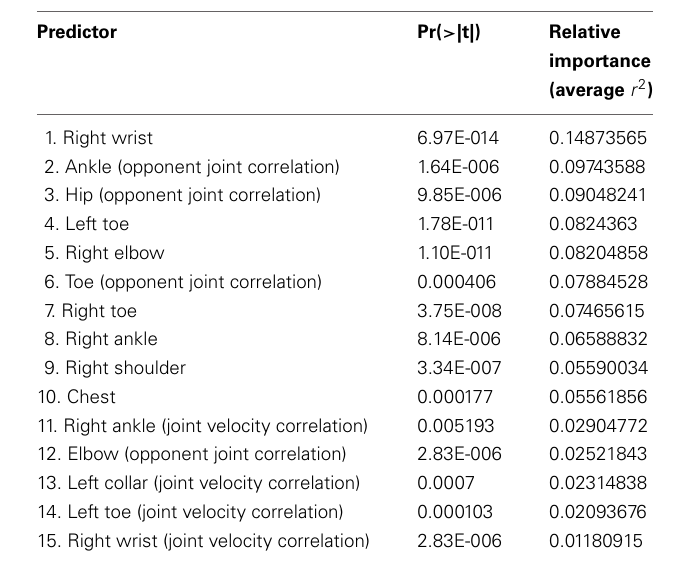
Table 1 | Predictors of the final model used to predict recognition performance from joint velocities.